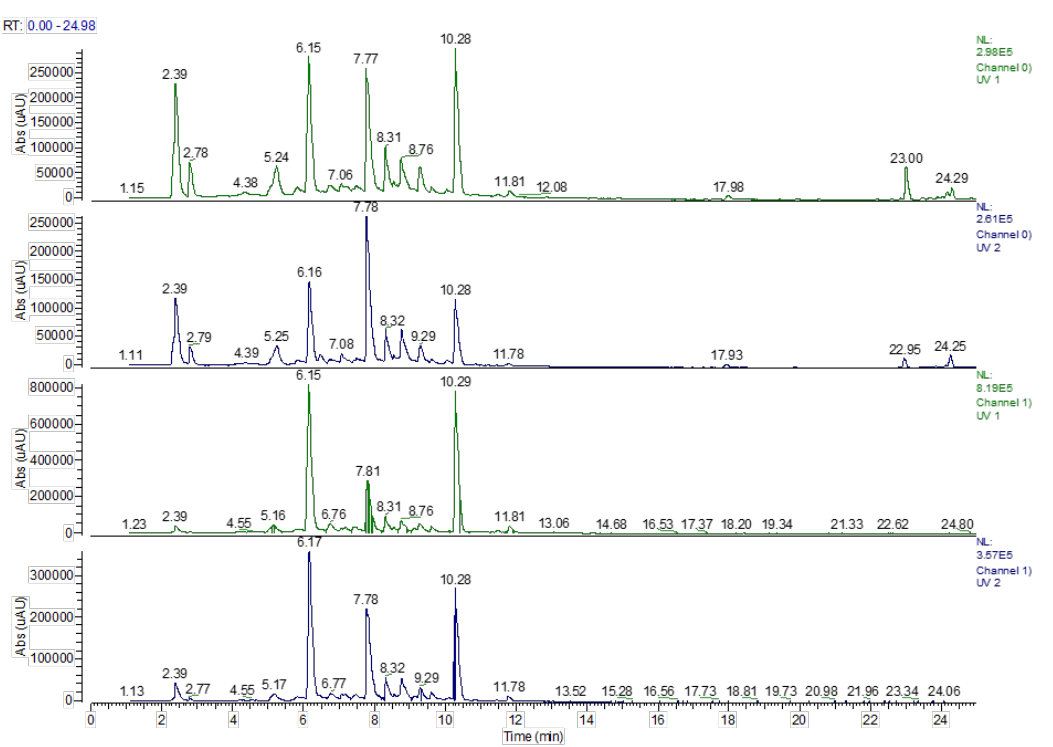
Figure 3. The UPLC-UV chromatograms of shoots from in vivo plants (green) and in vitro cultures (blue) of Eryngium alpinum L. extracts recorded at 270 nm (1,2) and 330 nm (3,4).